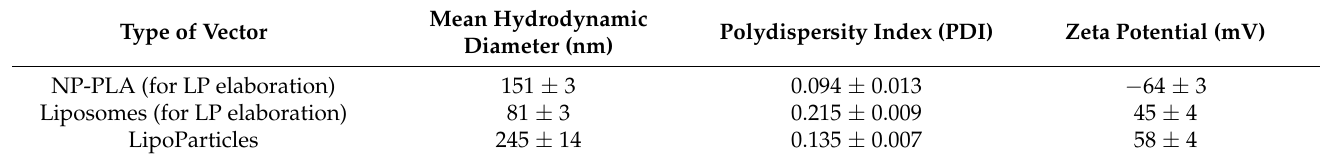
Table 1. Characterization of poly(lactic) acid nanoparticles (PLA-NP), 15/85 mol/mol 1,2-distearoyl-sn-glycero-3-phospho- choline (DSPC)/1,2-dioleoyl-3-trimethylammonium-propane (DOTAP) liposomes and LipoParticles (LP). Results are rep- resented as mean ± SD of different batches ( n = 3 for PLA-NP, n = 4 for liposomes and LP).